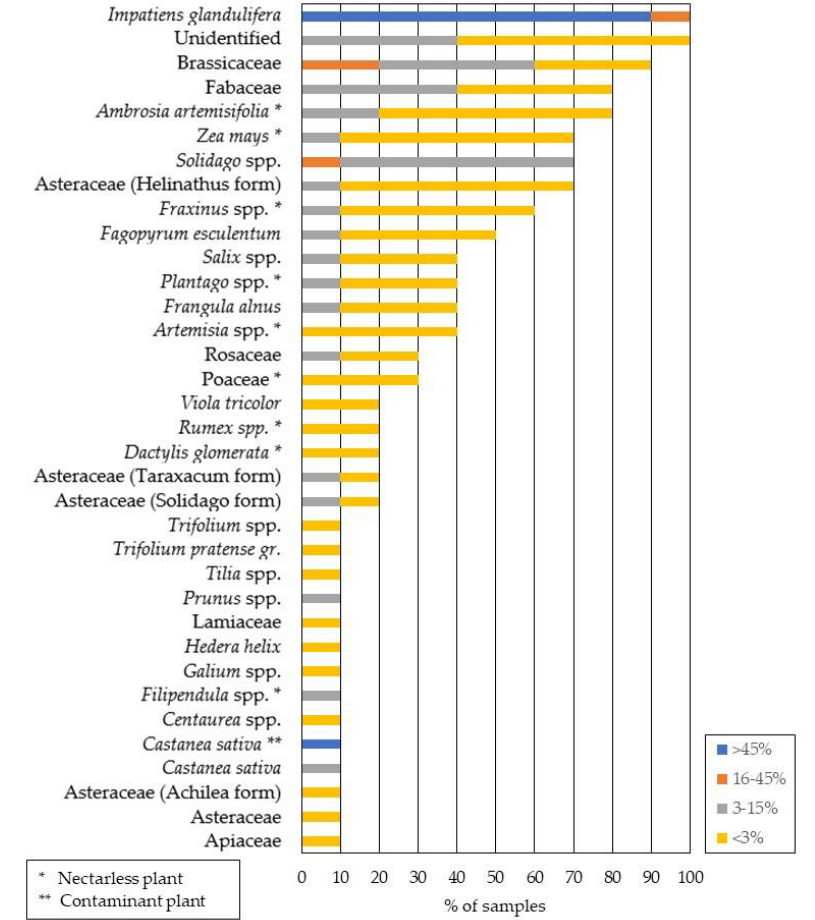
Figure 2. Pollen spectrum of Himalayan balsam honey (n = 10): predominant (>45%), secondary (16–45%), important minor (3–15%) and minor (<3%) pollen of plant taxa determined in analyzed honey samples.